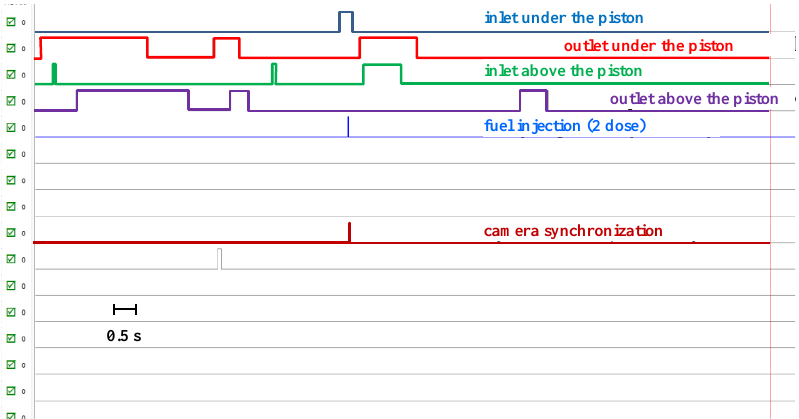
Figure 1. Settings of the TTL tracings with the description of their assignment. The physical outputs in the form of BNC connectors (Figure 2—sequencer) were connected to both the fast-varying signal recording device (IndiModul 621) and the actuator controlling the electromagnetic valves of the machine.